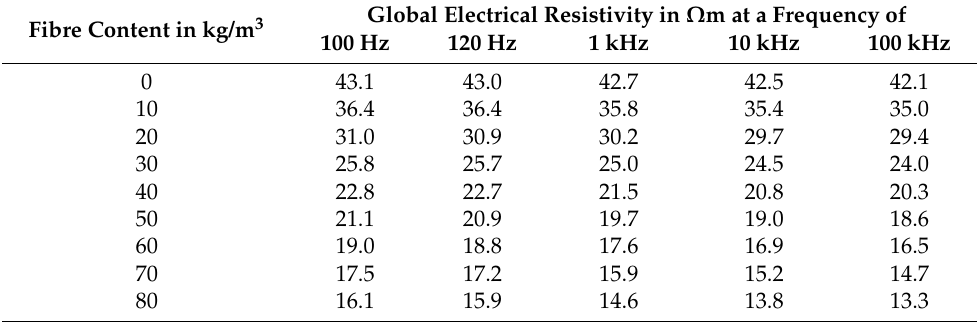
Table A19. Results of the resistivity measurements of the concrete mixture 32-60-300-00-F2. Fibre Content in kg/m 3